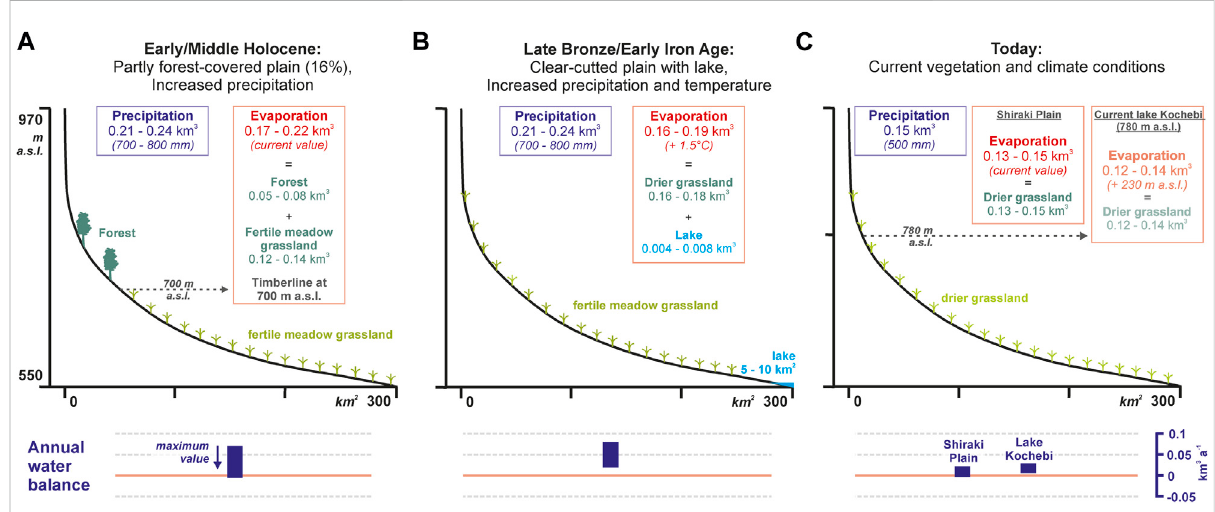
FIGURE 8 Water balance model of the Shiraki Plain for three different scenarios during the Holocene based on different annual precipitation and evapotranspirationvalues.Theresultingannualwater balancesareshowninthelowerpartsinblue: (A) Early/MiddleHolocene. (B)